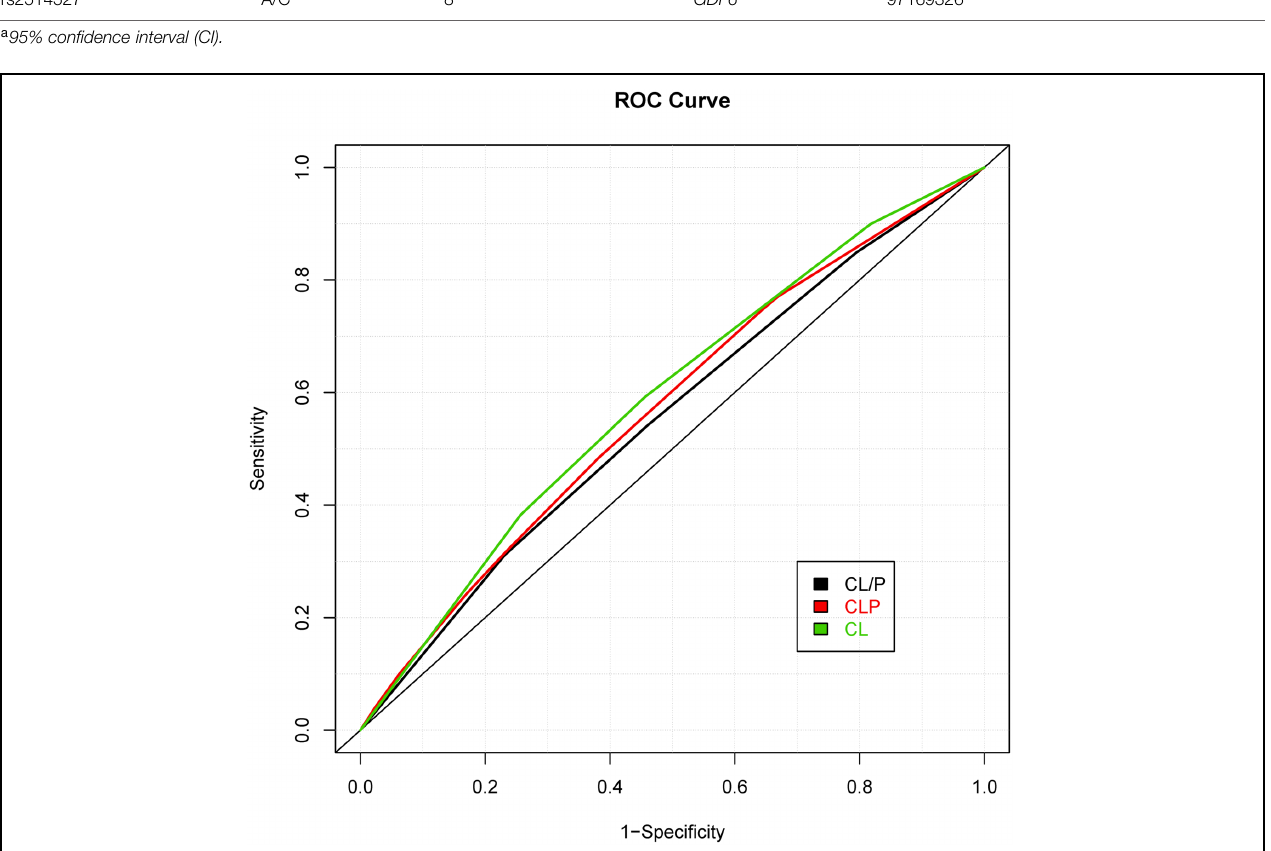
FIGURE 1 | Receiver operating characteristic (ROC) curves of risk prediction models for cleft lip with and without palate (CL/P), cleft lip with palate (CLP), and cleft lip only (CL).